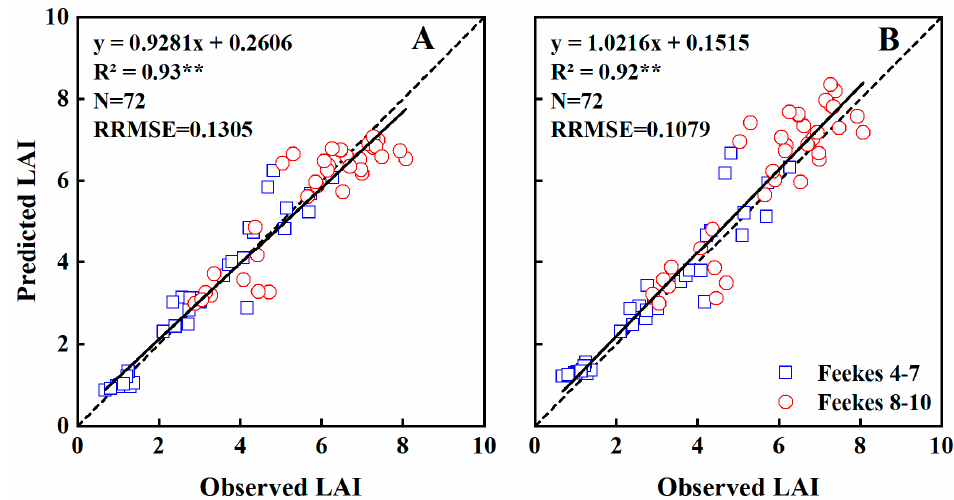
Figure 3. The relationships between observed and predicted LAI values of wheat varieties based on NDVI ( A ) and RVI ( B ) models in the Experiment 4 during vegetation growth period. The dotted line is inclined at 45° to the axes.